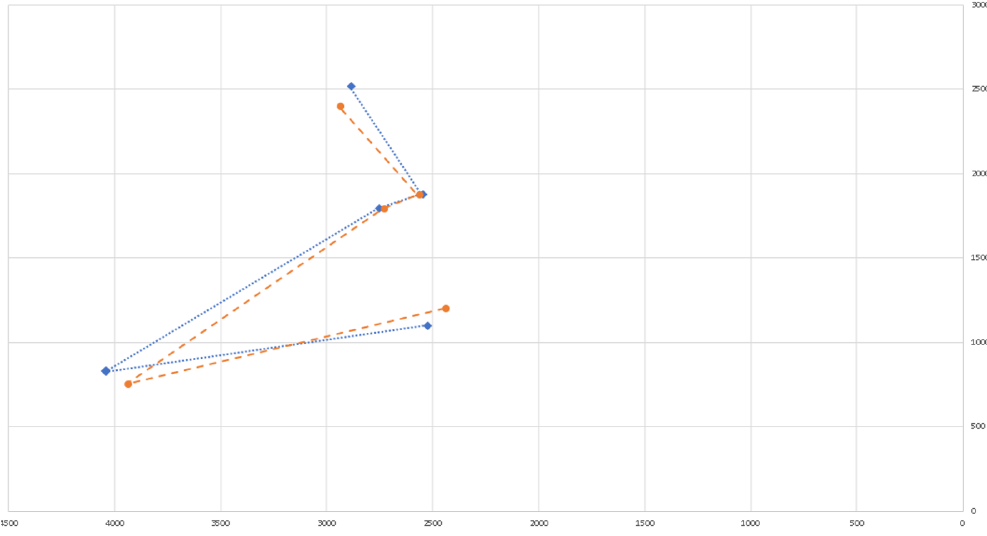
Figure 9. Two frames of stars from different locations.